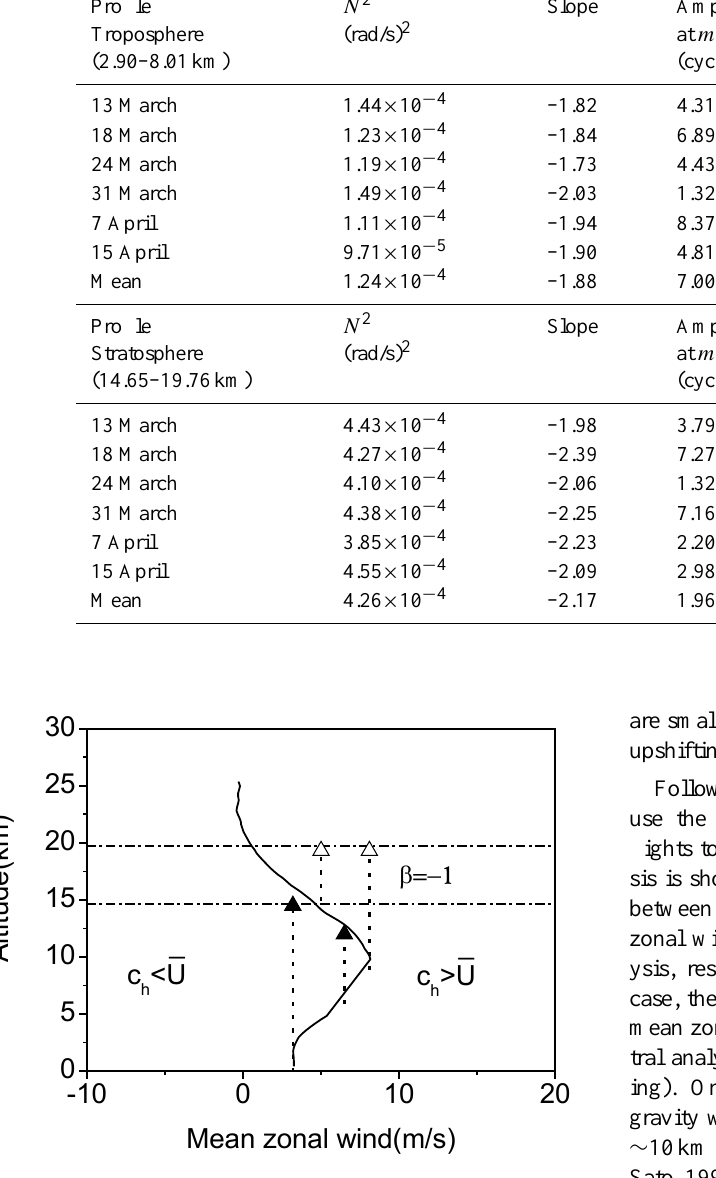
Figure 4. Mean zonal wind profile observed during March and April 2003 over the Beijing Meteorological Observatory (solid line). Upward pointing triangles represent upward propagating waves. The open triangles represent waves for which Uc > , whereas the solid triangles represent Uc h waves.